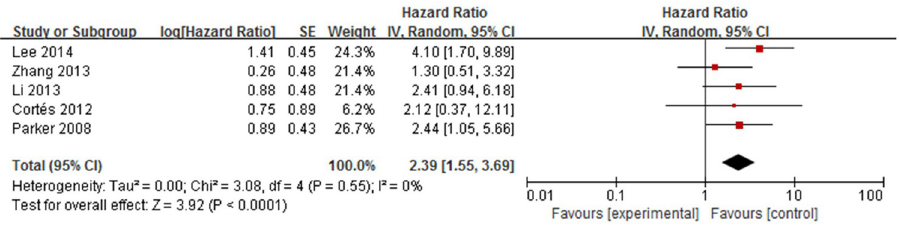
Fig 18. Forest plot of the association between diabetes mellitus and bullous pemphigoid